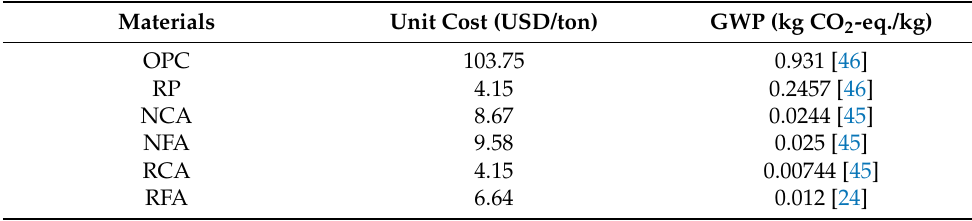
Table 5. Unit price and global warming potential of concrete components.